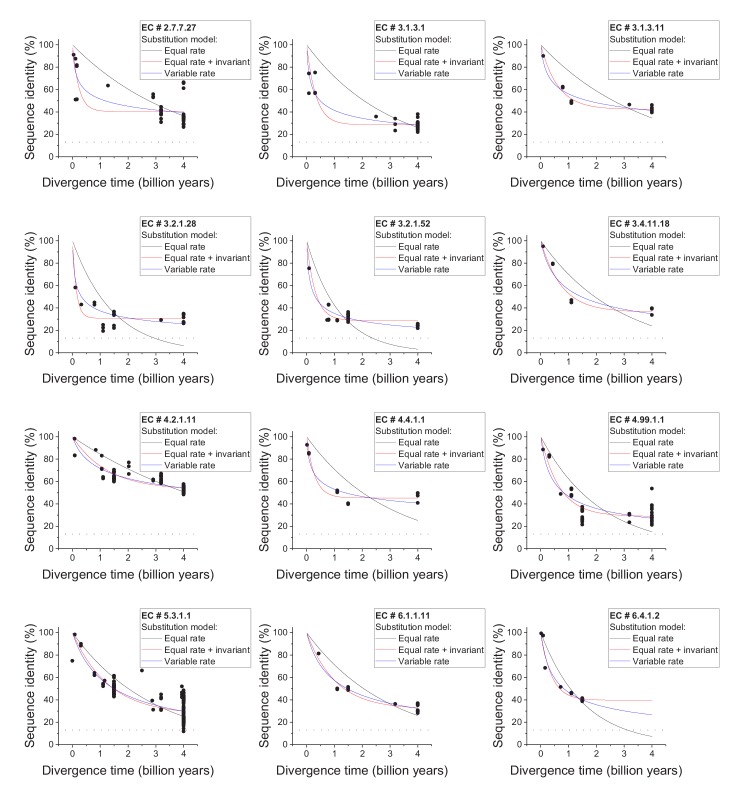
Divergence of orthologs with experimentally validated functional annotations.Sequence identity as a function of divergence time for orthologous enzymes annotated with the same EC number and experimentally validated molecular functions. The color lines indicate fits to the data for the three models of amino acid substitution (Equations 1-3). Results are shown for 12 different EC numbers. For all EC numbers, the Model 2 (red) gives a better fit to the data compared to the Model 1 (black, F-test p-value<0.05). Also, for all EC numbers the minimum sequence identity at long divergence times (Y0, from Equation 2) is higher than the average sequence identity between unrelated protein pairs (~13.5%, dashed black lines) (Wald-test p-value<0.05).10.7554/eLife.39705.007Figure 1—figure supplement 3—source data 1.Sequence identity versus divergence times for experimentally validated enzymes.